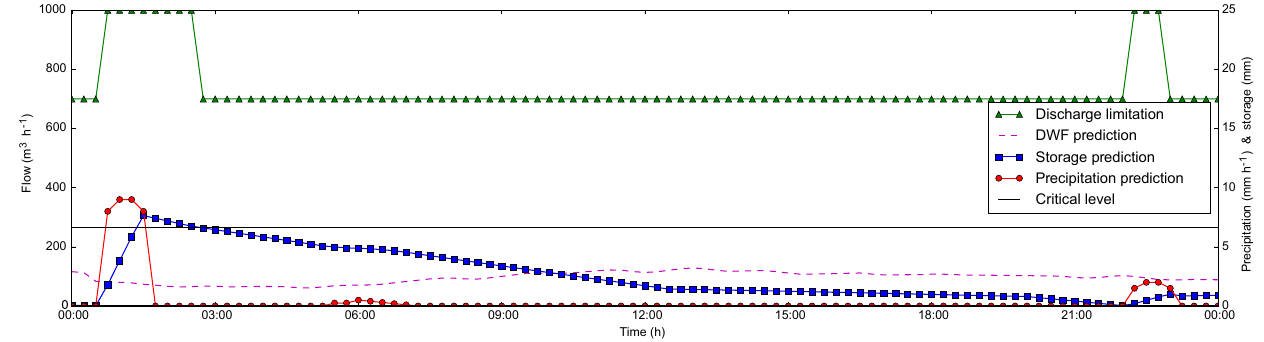
Figure 1. Outline of the predictive control for the influent flow of WWTP Bennekom (Icke et al.,